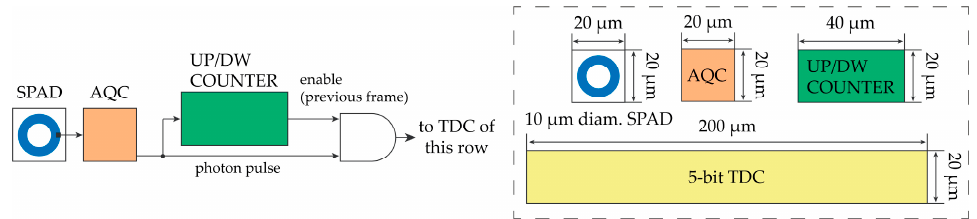
Figure 11. Possible hardware implementation of the laser spot tracking ( left ) and tentative dimen- sions of SPADs, AQCs, counters, and shared TDCs in a 160 nm CMOS technology ( right ).